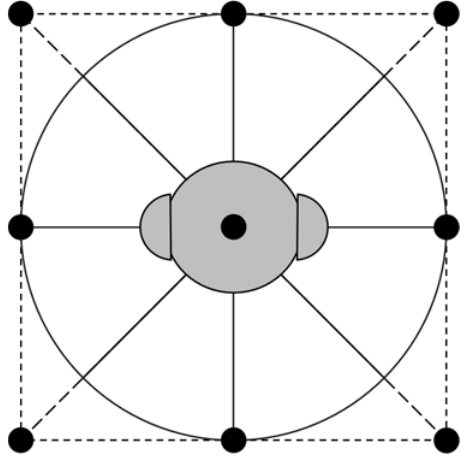
Figure 1. Illustration of a sound spatial positioning from Drossos et al.